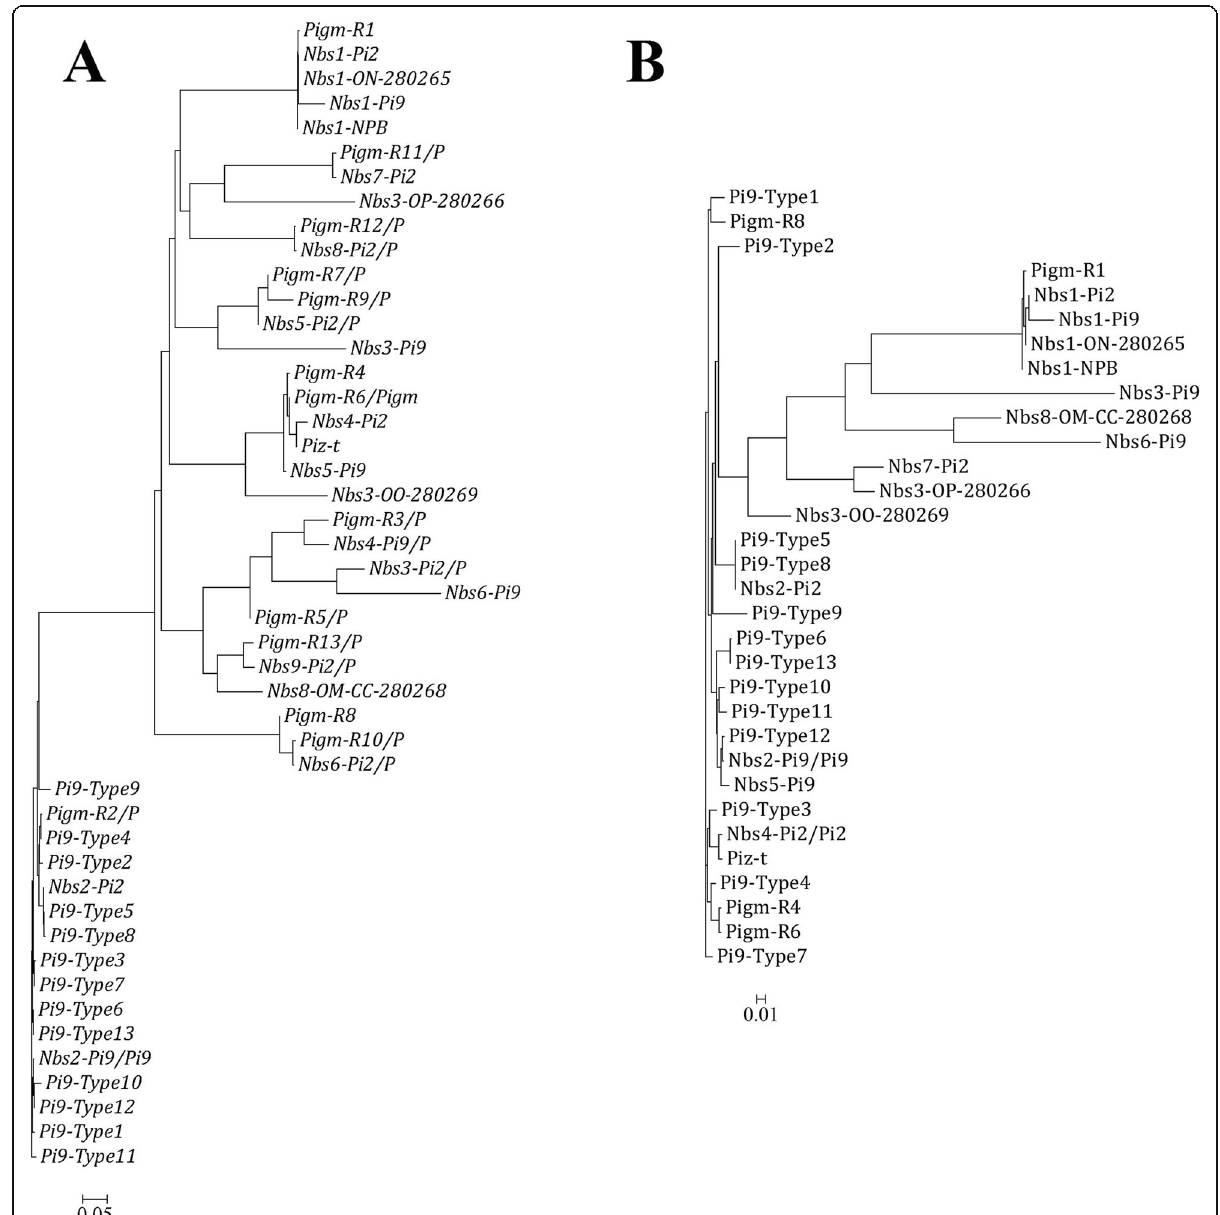
Fig. 3 Phylogenetic relationship among gDNA and protein sequences of NBS genes at Pi2 / 9 locus.Thirteen new Pi9 allele sequences found in our research materials and the sequences of Pi9 , Pi2 , Piz-t , Pigm , and all NBS disease resistance genes at the tandem repeat region of the Pi2 / Pi9 locus were used for analysis. a . Phylogenetic tree of the genomic sequences (from ATG to TGA, including the introns) for 13 novel Pi9 alleles based on our sequencing results and NBS genes at Pi2 / 9 locus; b . Phylogenetic tree of the protein sequences of 13 novel Pi9 alleles protein and NBS proteins at Pi2/9 locus. Bootstrap values (1000 replications) are mentioned at the branch